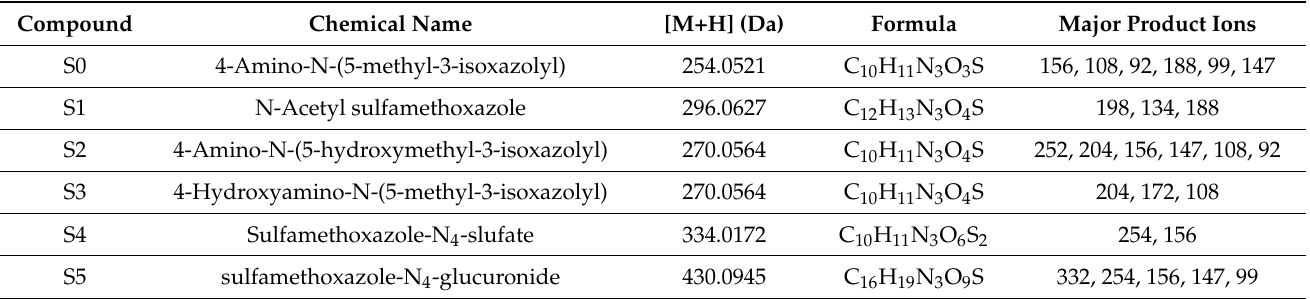
Table 2. Metabolite information of SMZ in pigs, chickens and